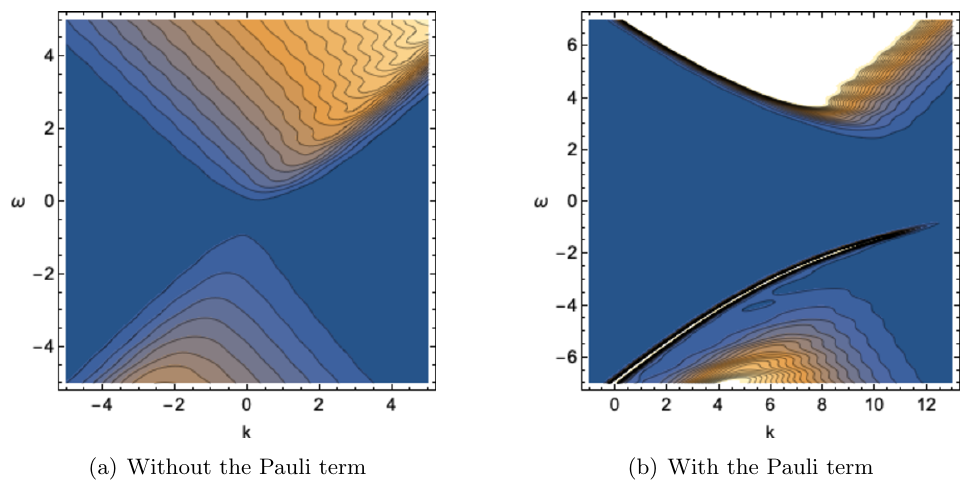
Figure 1 . Fermion spectral functions. (a) Before the Pauli term is added. No particle nature. (b) After the Pauli term is added, a new branch appears, implying new quasi-particle creation. The background used is the RN black hole with chemical potential (cid:22) = p = 0 and 10 for (a) and (b)